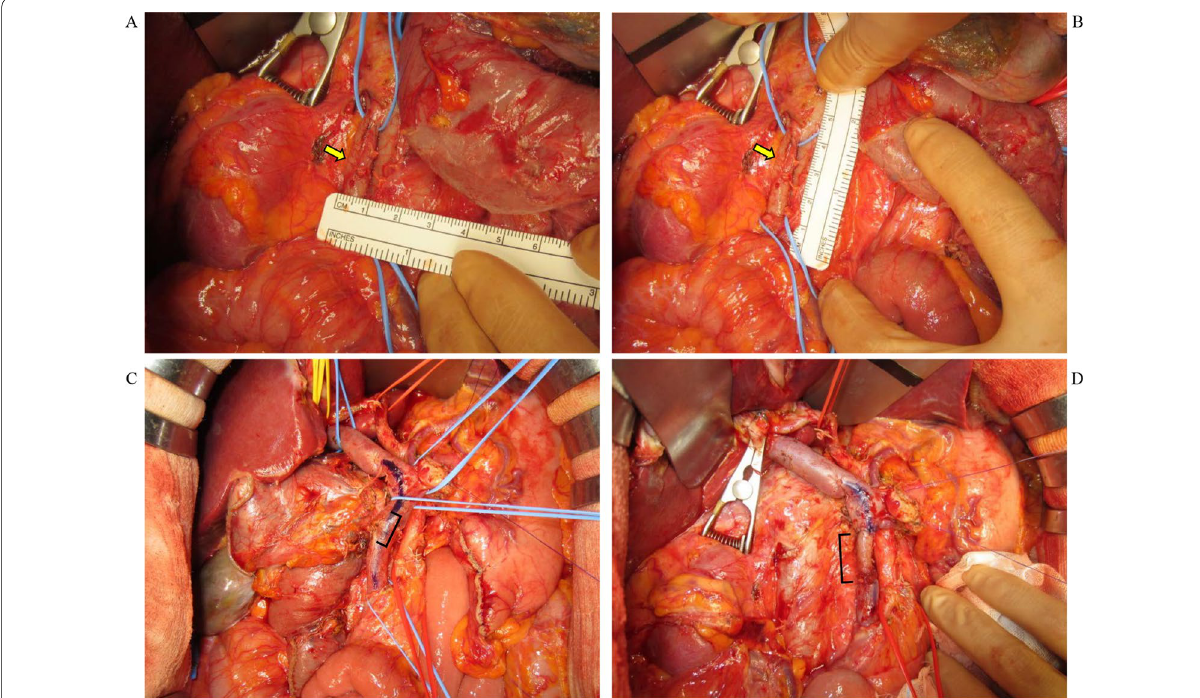
Fig. 3 Intraabdominal findings during the operation. A and B Dilated right ovarian vein to be used for the graft. C Superior mesenteric vein invaded by the pancreatic tumor. D Superior mesenteric vein after reconstruction using the right ovarian venous